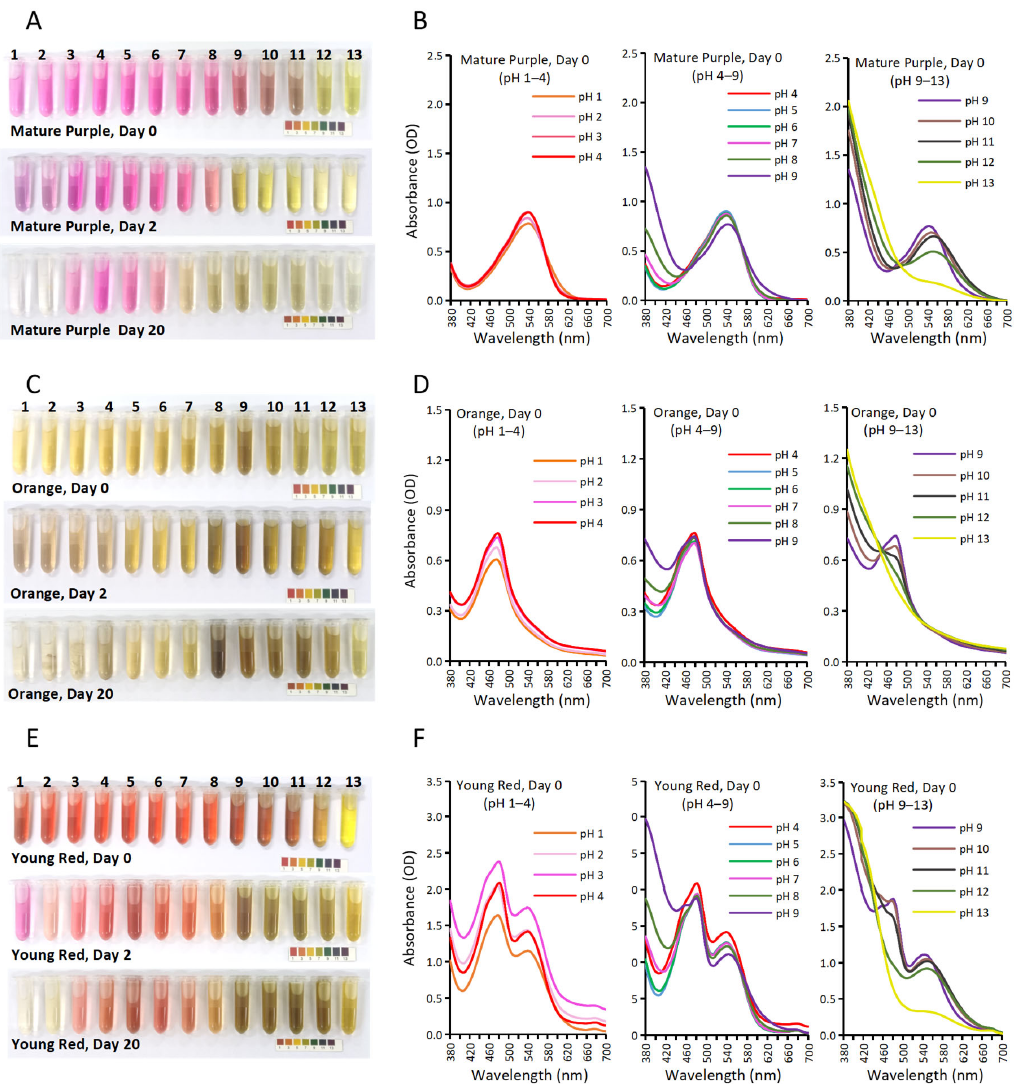
Figure 4. Color stability and spectra analysis for BBEs at different pHs. Colors of BBEs at different pHs on storage on Day 0, Day 2, and Day 20 were shown for “3 Mature Purple” ( A ), “7 Orange” ( C ), and “4 Young Red” ( E ). Their respective spectra ( B , D , F ) on Day 0 were demonstrated. The universal pH indicator papers were shown as color references.